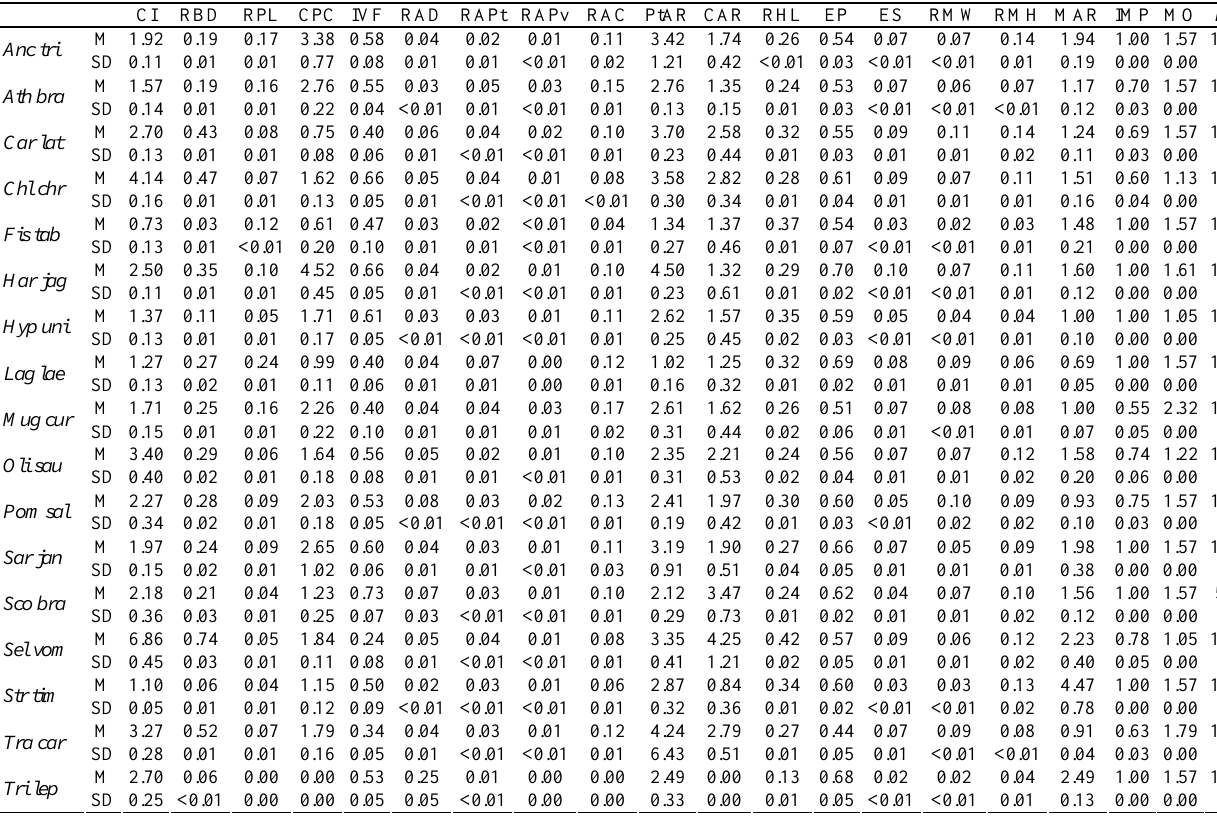
CI RBD RPL CPC IVF RAD RAPt RAPv RAC PtAR CAR RHL EP ES RMW RMH MAR IMP MO n M 1.92 0.19 SD 0.11 0.01